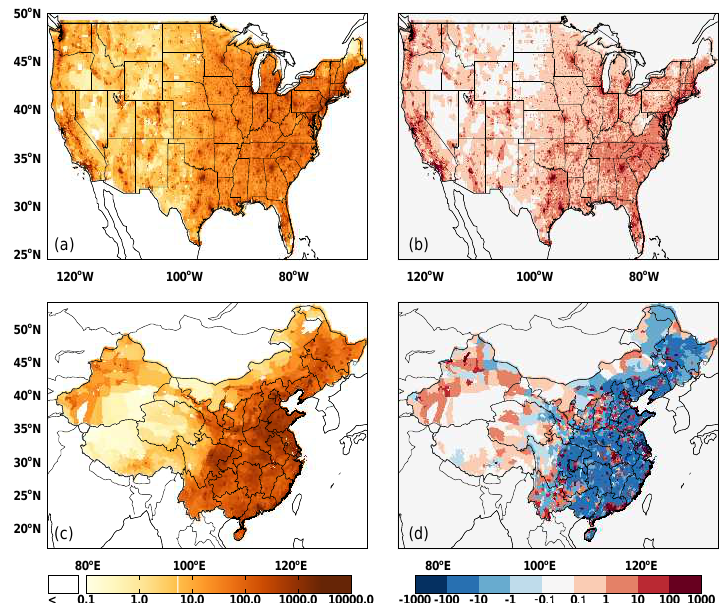
Figure 1. Population density (per km 2 ) for the year 2000 from the GPWv3 data for (a) the continental US and (c) China. The projection for increase in population density by the year 2015 for (b) the continental US and (d)